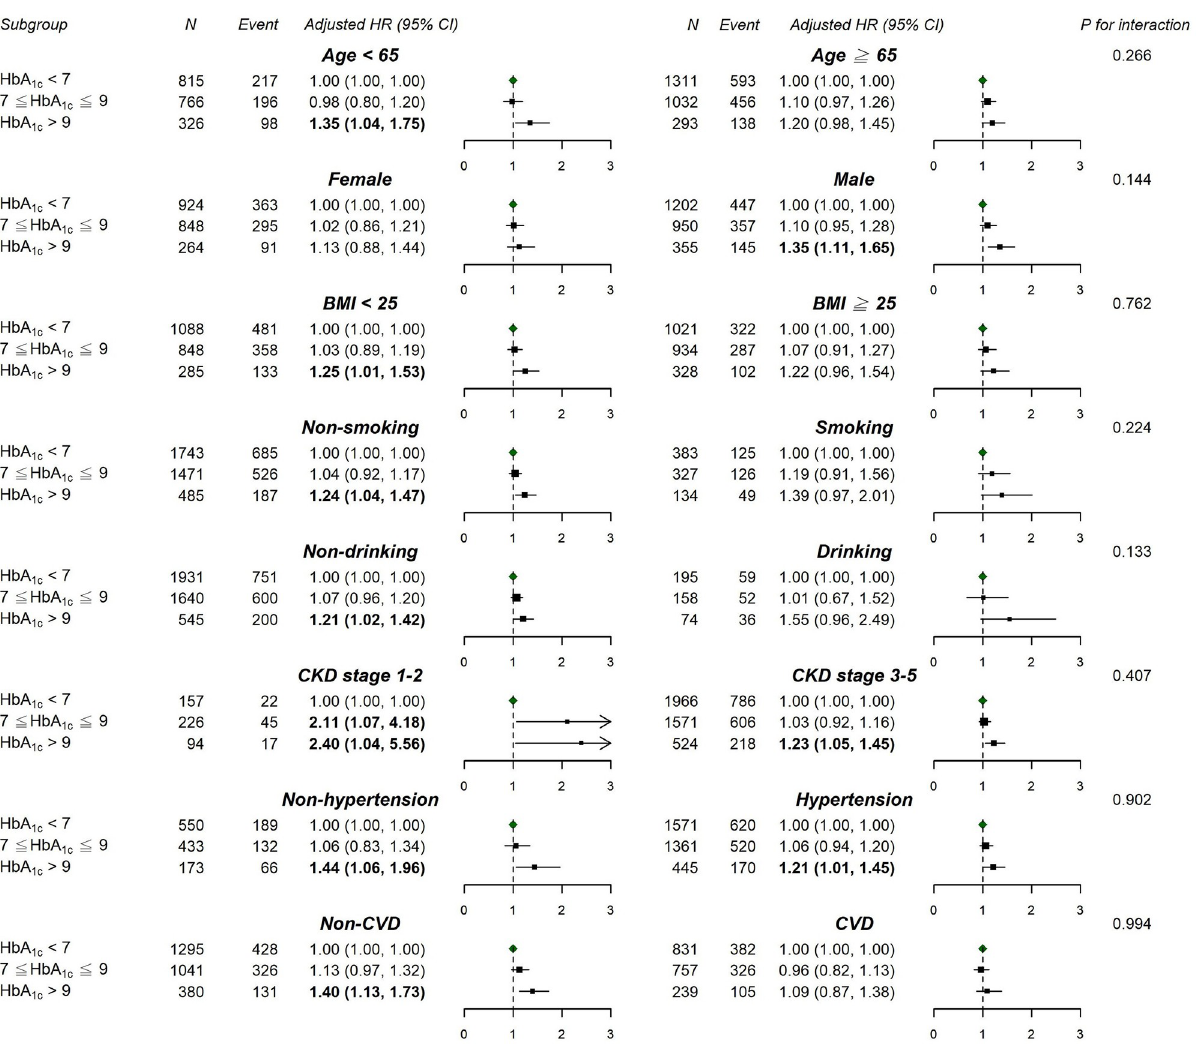
Fig 4. Subgroup analysis of the hazard ratios (95% confidence interval) of all-cause mortality associated with baseline HbA 1c groups. BMI: body mass index, CKD: chronic kidney disease, CVD: cardiovascular